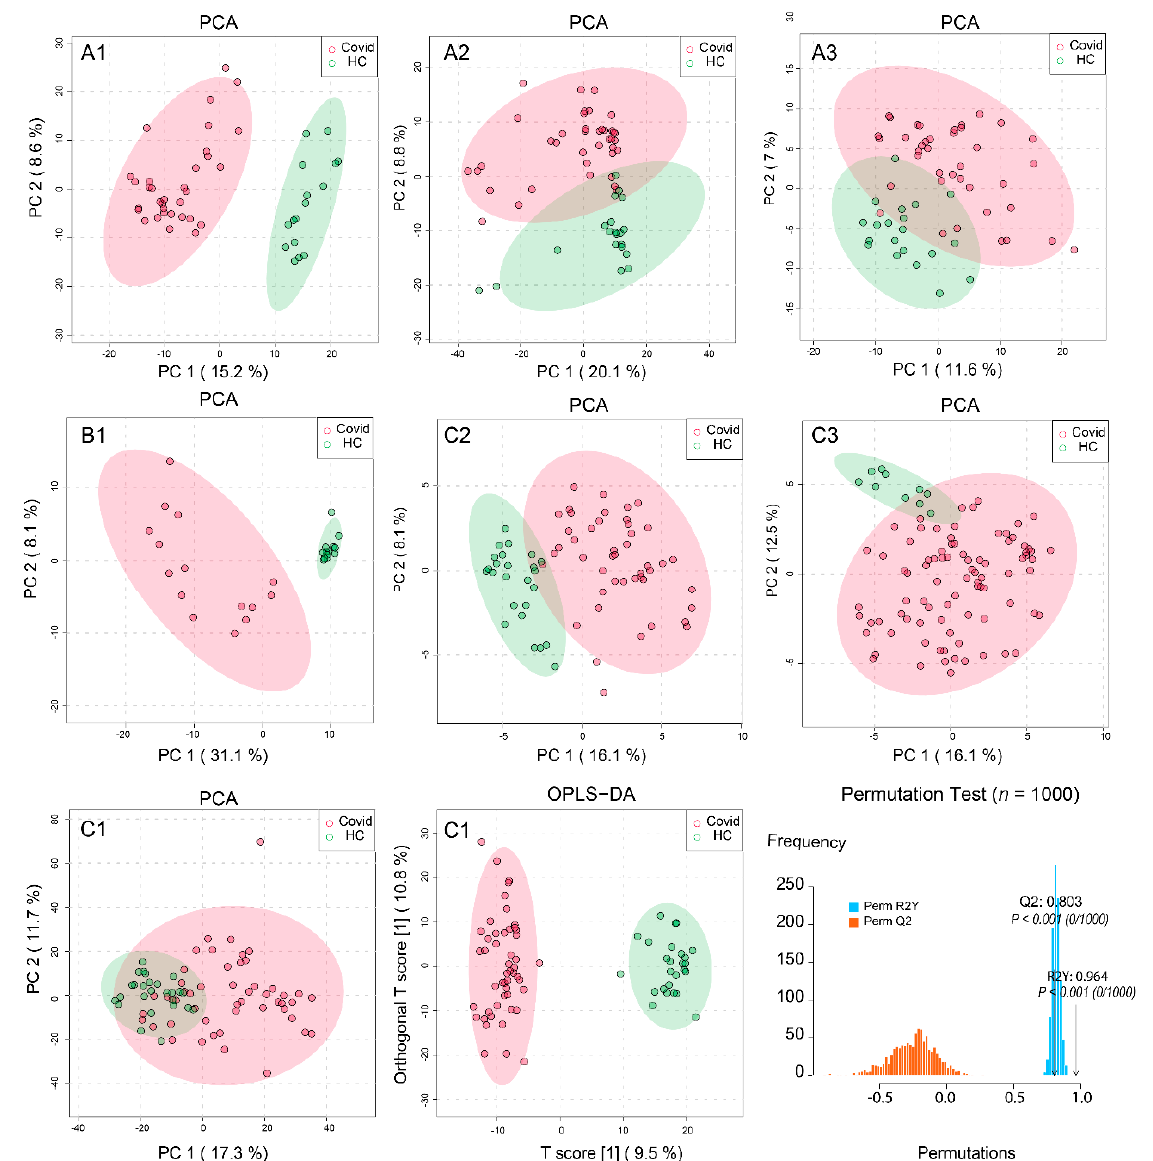
Figure 2. Overview of the separation patterns between COVID-19 and healthy controls (HCs) across the seven datasets. The 1st and 2nd rows are the principal component analysis (PCA) results of datasets A1 , A2 , A3 , B1 , C2 and C3 , respectively. For C1 (3rd row), we performed PCA, followed by Orthogonal Projections to Latent Structures Discriminant Analysis (OPLS-DA) and its validation by permutations ( n = 1000).